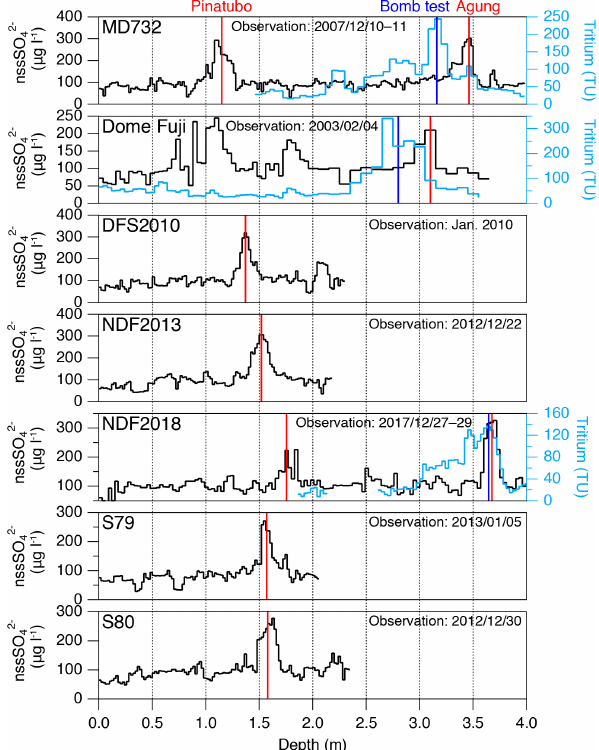
− concentration and tritium content for snow Figure 4. The nssSO 2 4 pits. The data for MD732 are from Hoshina et al. (2014). Vertical bars represent the depths of volcanic eruptions (red) and the past bomb test (blue) for age controls.